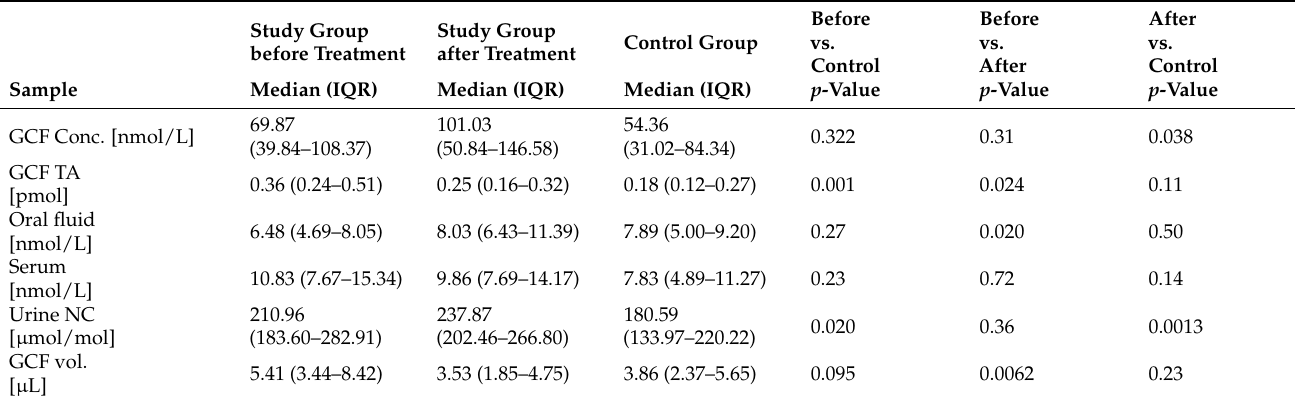
Table 2. Neopterin levels in gingival crevicular fluid, oral fluid, serum and